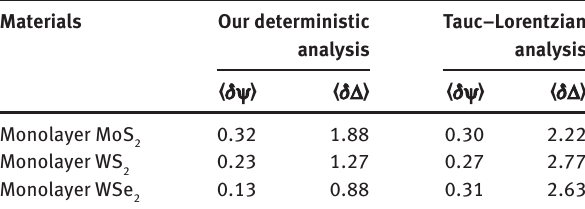
Table 1: Summary of the spectral averaged errors 〈 δ ψ 〉 and 〈 δ Δ